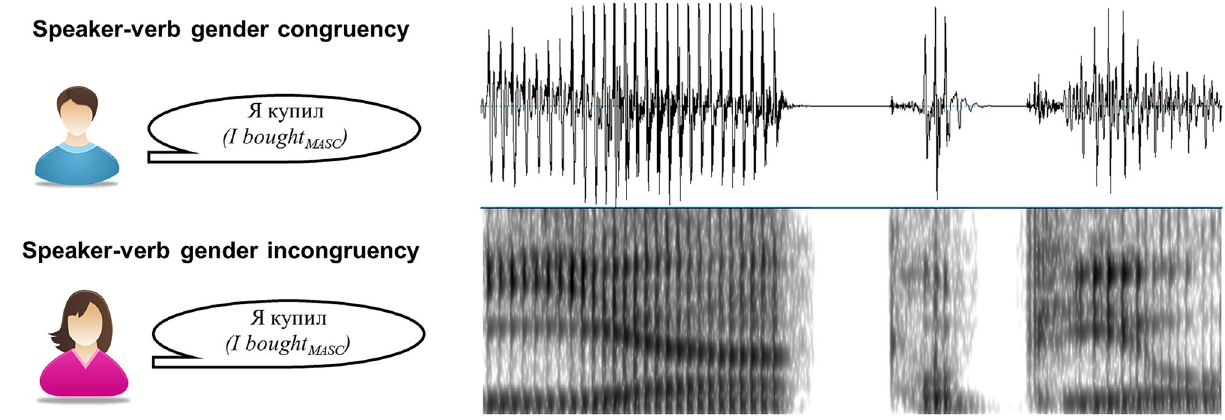
Figure 1. Example of an experimental stimulus (“ ja kupil; I bought MASC ”) presented in both congruent and incongruent conditions, together with its waveform and